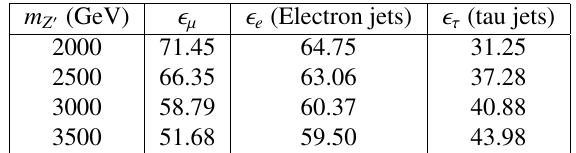
Figure 4. The plot gives the comparison of corresponding sensitivity as a function of σ Z fb − 1 for two di ff erent bin choices: The left column corresonds to a choice M Z right column corresponds to M Z 500 GeV. Note that for all cases we assume B.R( Z (cid:31) (cid:31) ± ee ) B.R( Z (cid:31) → m Z (GeV) (cid:29) µ (cid:29) e (Electron jets) (cid:29) τ (tau jets) (cid:31)